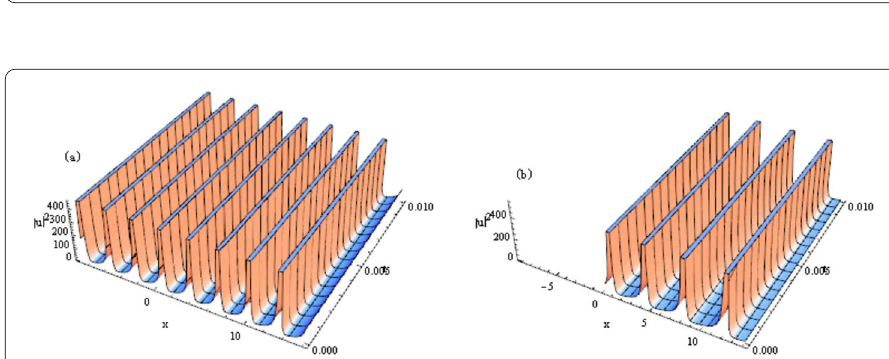
Figure 3 ( a ) The evolution plot of the triangular functions solutions of u 24 with the parameters k = k